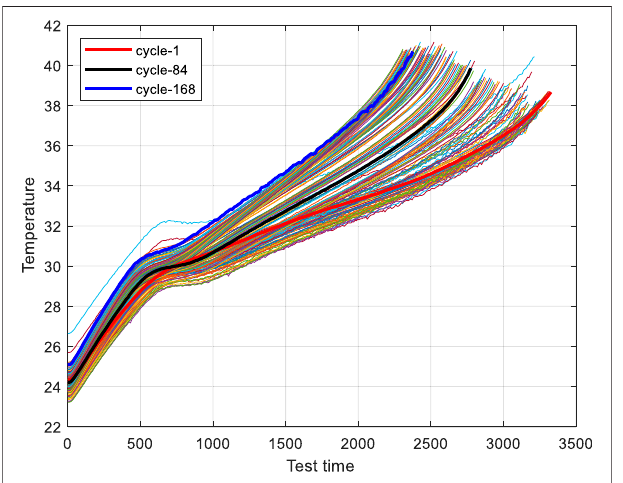
FIGURE 9 | SOC-Time relationship diagram of battery #2.